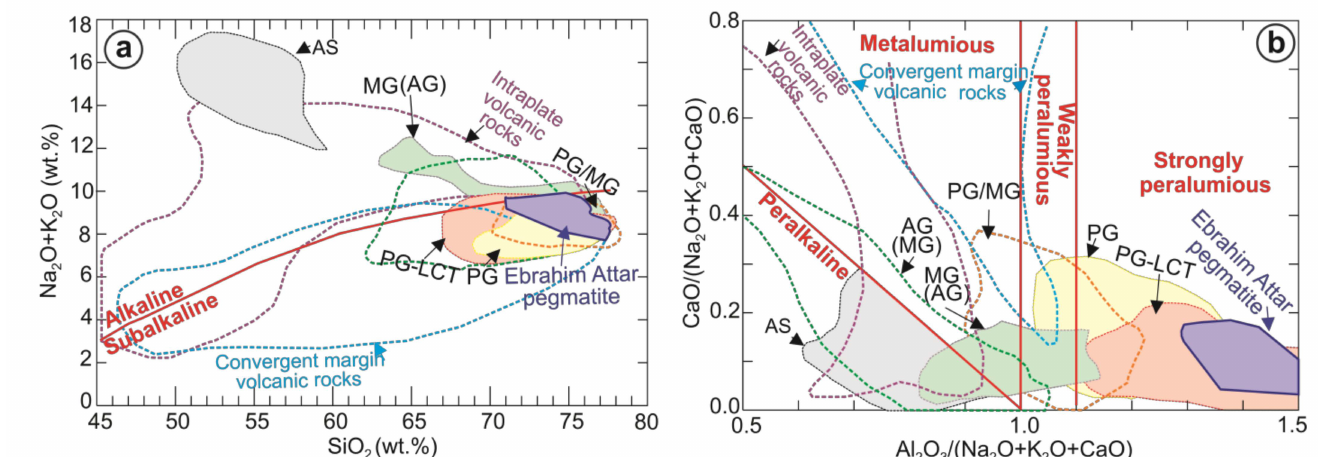
Figure 8. ( a ) Total alkali vs. silica plot with fields of selected whole-rock chemical data of Be deposits [4]. The compositional division of alkaline and subalkaline is from Wilson [54]. The Ebrahim-Attar granitic pegmatites plot in the LCT-type field. ( b ) CaO/(Na 2 O + K 2 O + CaO) vs. Al 2 O 3 /(Na 2 O + K 2 O + CaO) plot (wt.%) with the projection of composite Be deposit data [4]. The Ebrahim-Attar granitic pegmatites show a strongly peraluminous signature. Data for the Ebrahim-Attar granitic pegmatites are from Azizi et al. [30]. PG-LCT = LCT-type; PG = strongly peraluminous; PG/MG = peraluminous granite; MG (AG)= metaluminous granite; AG (MG) = peralkaline; (AG) = peralkaline